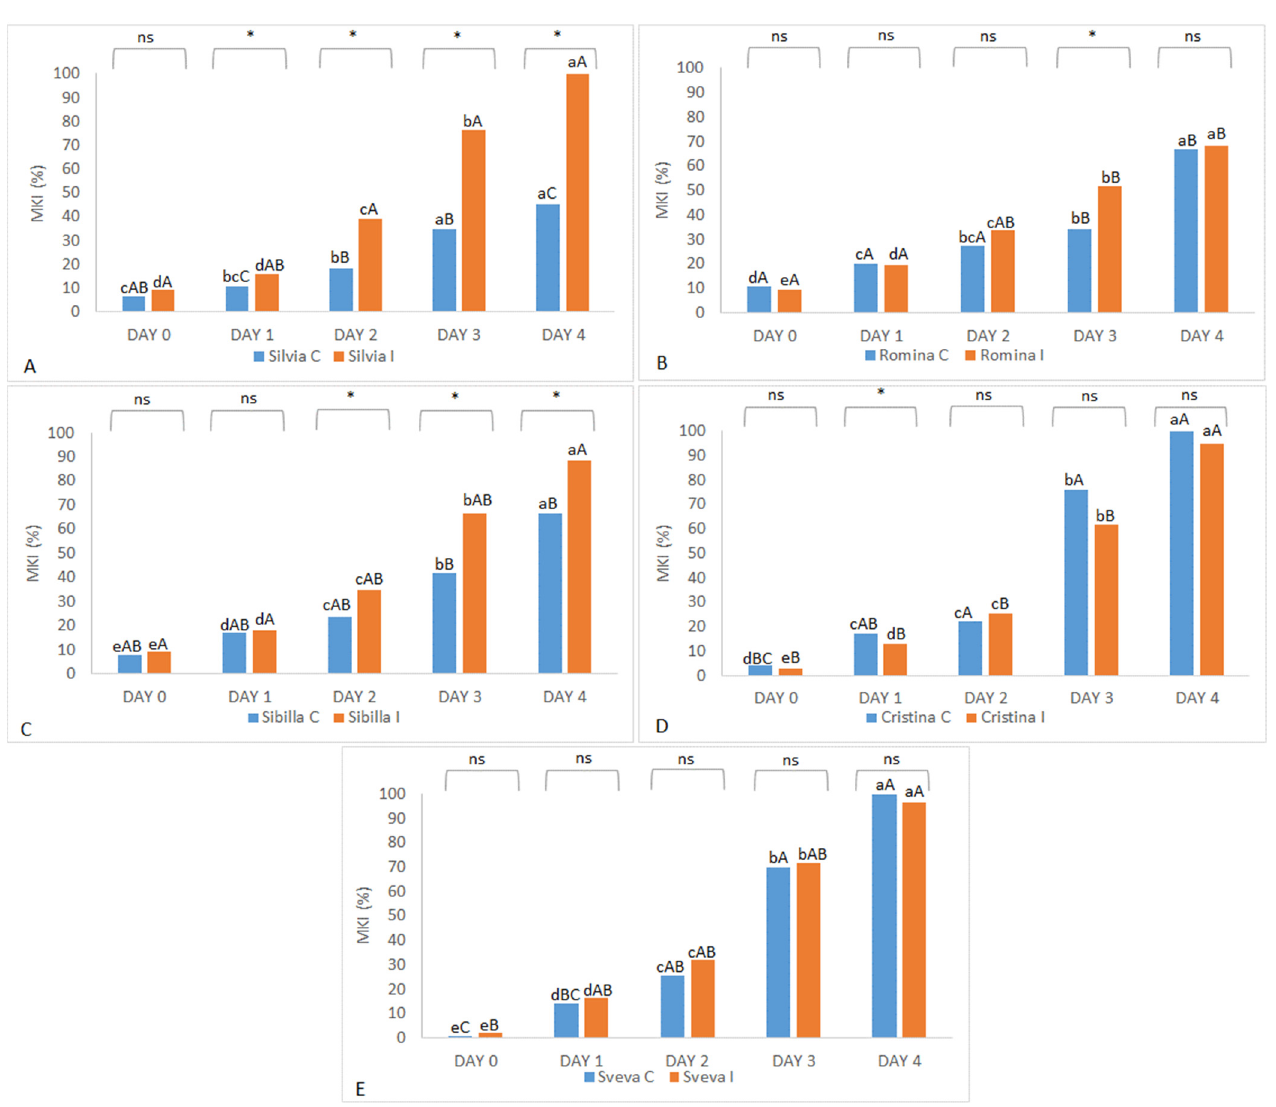
Figure 3. McKinneyindex (MKI) of postharvest decay of the ( A ) Cristina, ( B ) Romina, ( C ) Sibilla, ( D ) Cristina, and ( E ) Sveva strawberry fruits in the 2021 harvest season. Blue bars represent the control samples (not infected), and orange bars represent the infected samples (with B. cinerea spores). Strawberries were stored for 4 days at 20 ± 1 °C, and 90% relative humidity. Different lowercase letters indicate a significant difference ( p ≤ 0.05, Tukey test) between fruits of the same treatment of the same cultivar at different days. Asterisks indicate a significant difference ( p ≤ 0.05, Tukey test) between control and infected fruits of the same cultivar at the same days (ns: not significant). Different uppercase letters indicate a significant difference ( p ≤ 0.05, Tukey test) between fruits of the same treatment of different cultivars at the same days.